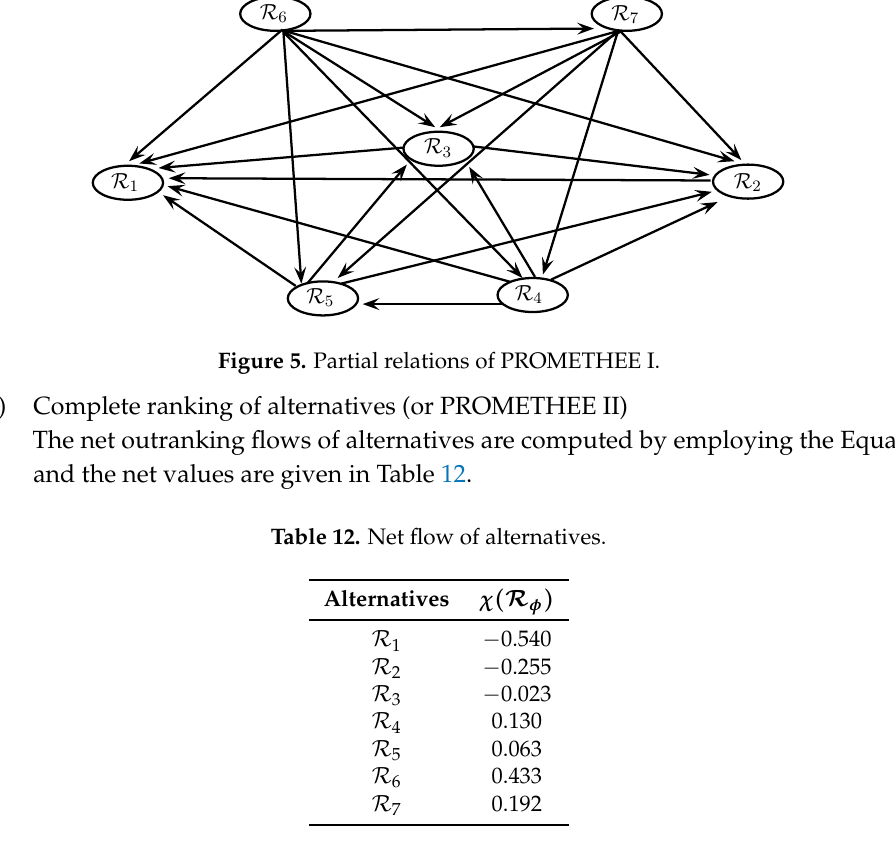
Table 10: Multi-criteria preference index R 1 − Table 11: Positive and negative outranking flows Alternatives